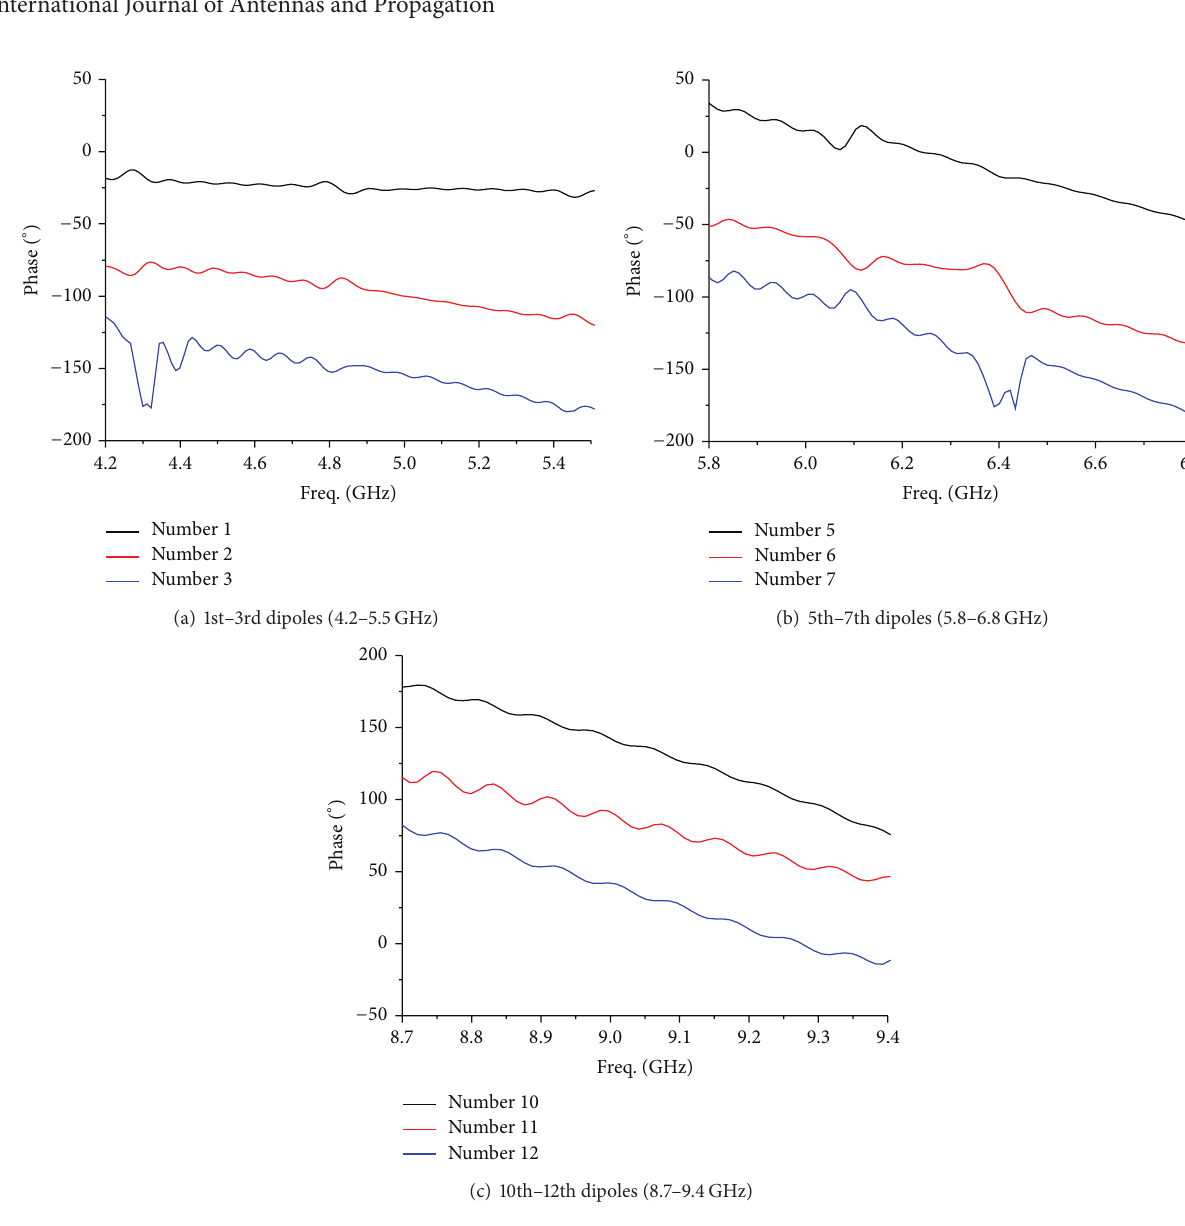
Figure 5: Phase of each dipole in corresponding